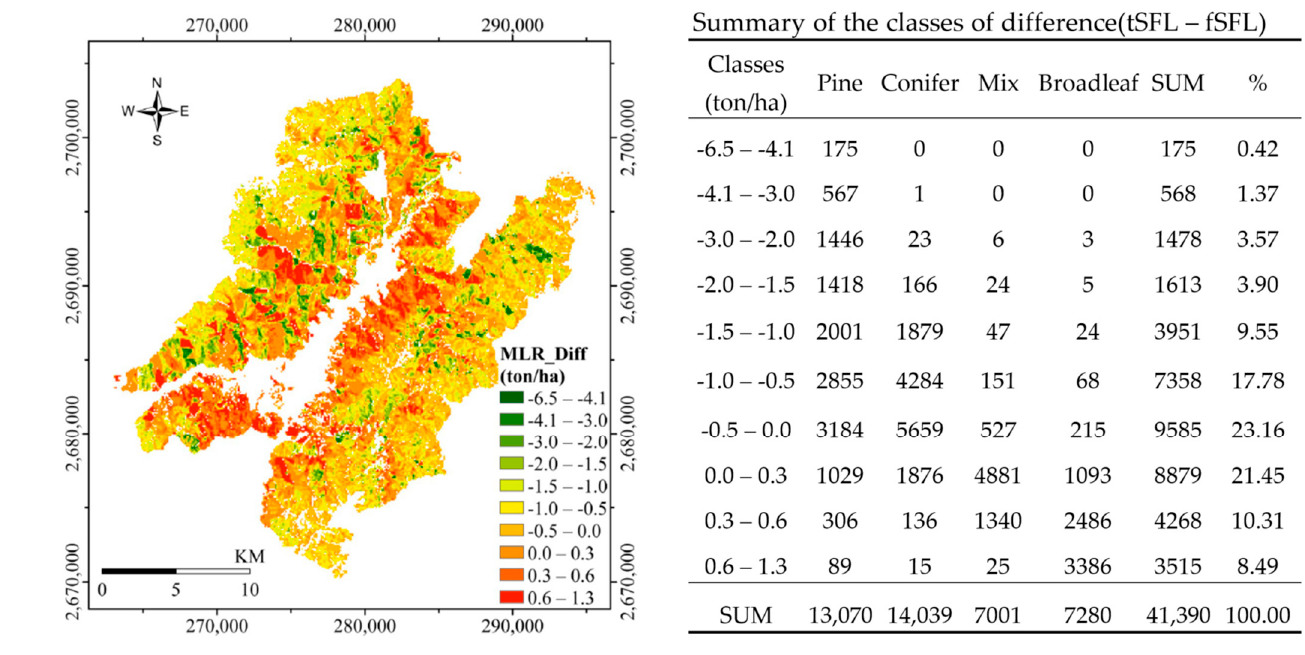
Figure 8 . Map of the difference between MLR-derived tSFL and fSFL estimates over the study site. The negative values are a result of larger fSFL and smaller tSFL, indicating prediction uncertainty in the lntSFL – BioTopo model.